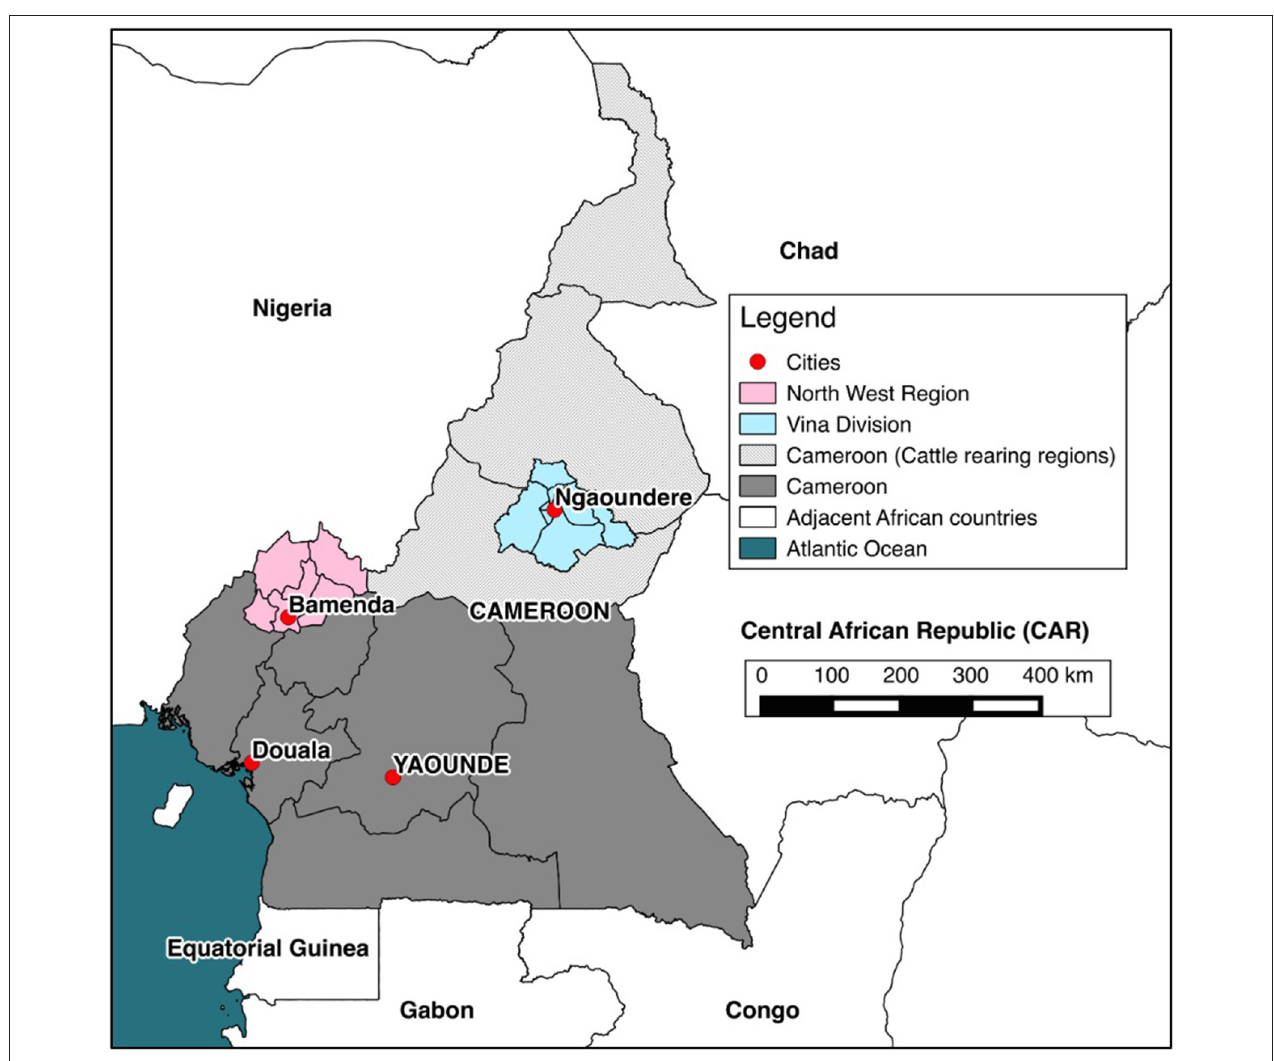
FIGURE 1 | Map of Cameroon. The location of cattle rearing areas (light gray), study sites (pink and blue) and major cities